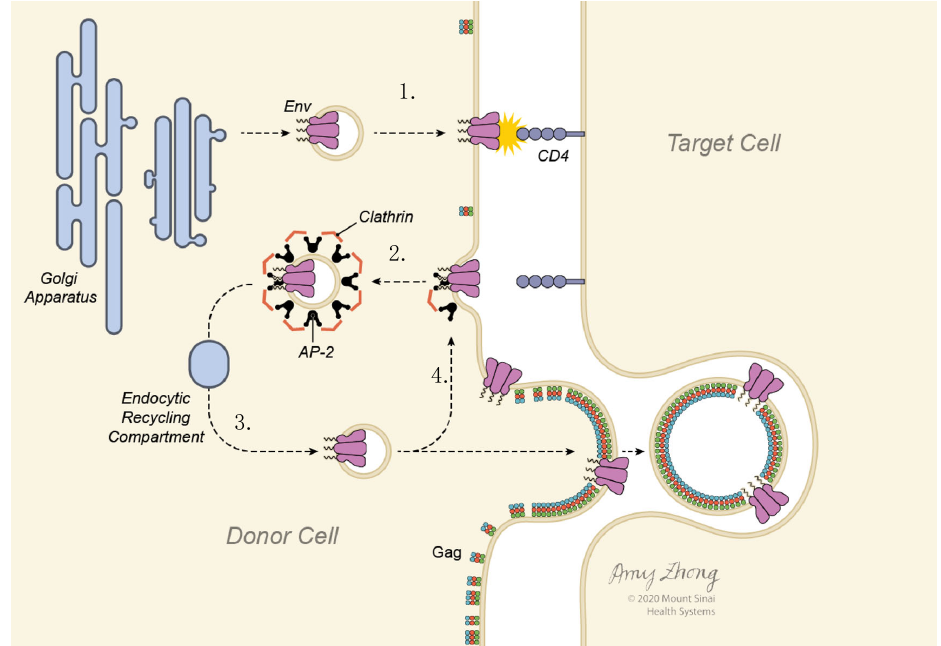
Figure 7. Model of Env trafficking pathways that support Env accumulation at the VS. ( 1 ) Env is transported to the cell surface following synthesis through the ER/Golgi pathways. ( 2 ) Clathrin ‐ mediated endocytosis is initiated by recognition of the Env cytoplasmic tail by adapter protein complex, AP ‐ 2, which recognizes the membrane proximal tyrosine motif in Env. ( 3 ) Following internalization Env is recycled back to the cell surface, selectively trafficking to the VS where it can be incorporated into nascent virus particles. ( 4 ) Env at the VS continues to recycle while Gag does not exchange.